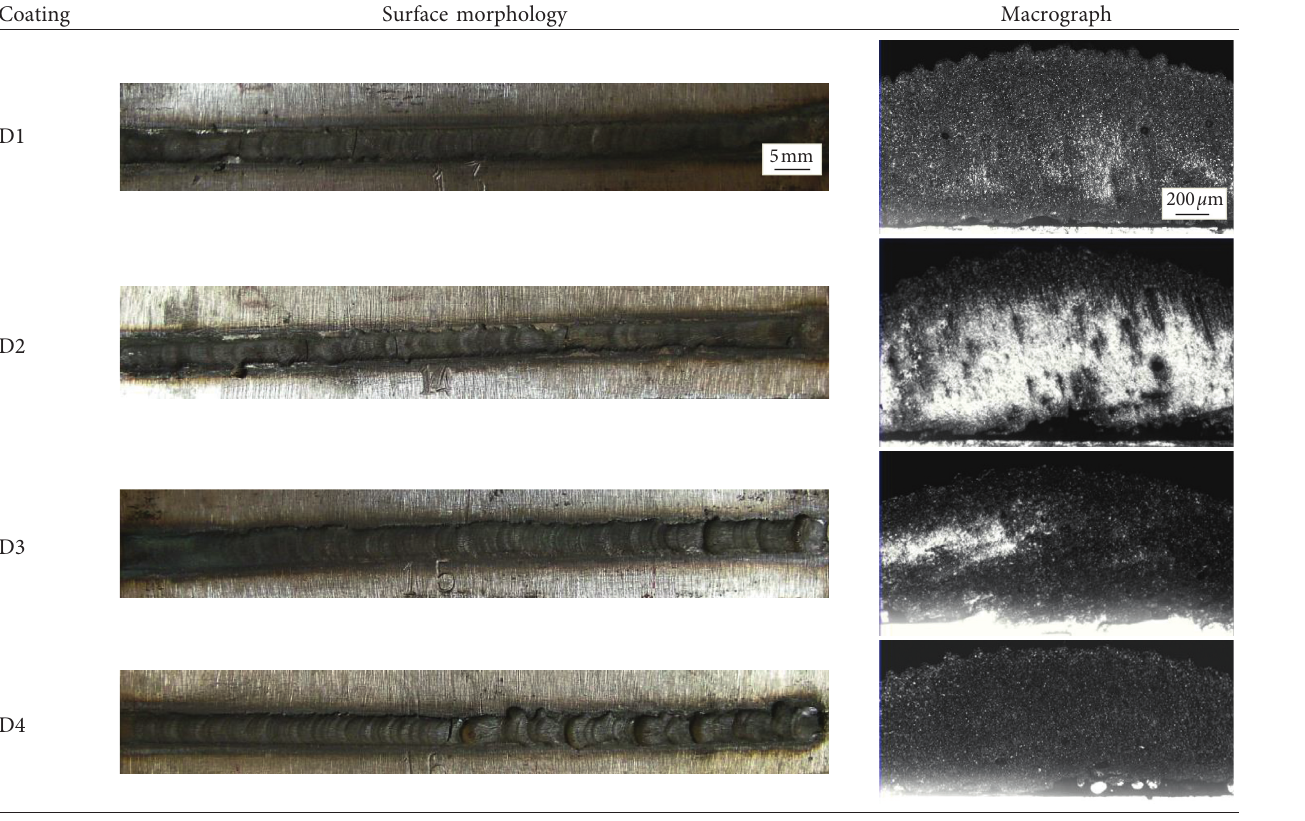
Table 6: The surface morphology and macrograph of the D